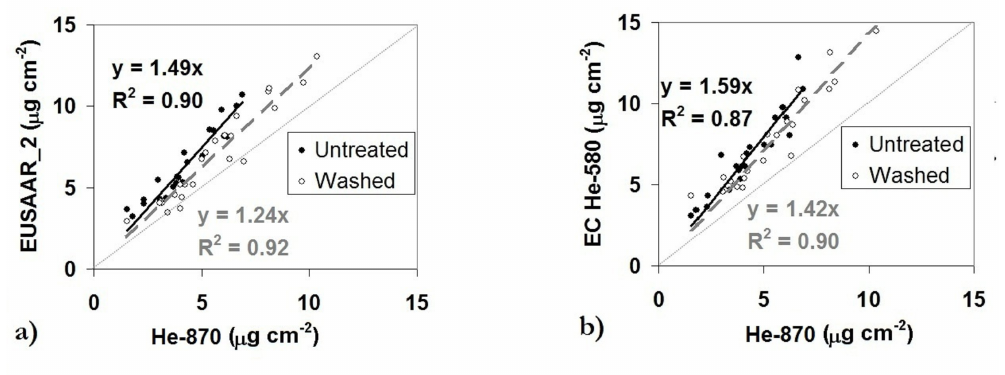
Fig. 2. Comparison between the EC results obtained by EUSAAR 2 and He-870 (a) , He-580 and He-870 (b) on untreated and washed samples.